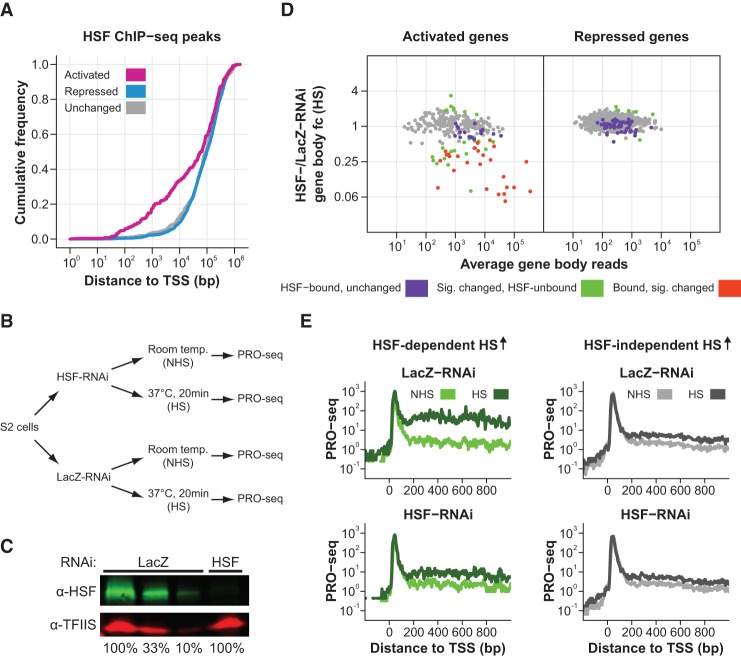
HSF is essential for the induction of only a small minority of HS-activated genes and activates genes by stimulating the release of paused Pol II. (A) Cumulative distribution plots of the distance between the closest HSF ChIP-seq peak and the TSS of each gene in the HS-activated (n = 249), HS-repressed (n = 2300), and unchanged (n = 517) classes. (B) Experimental setup. Drosophila S2 cells were treated with either HSF-RNAi or LacZ-RNAi for 5 d. Nuclei were then isolated for PRO-seq after cells were incubated at room temperature (NHS) or heat-shocked for 20 min (HS). (C) Western blot of whole-cell extracts from LacZ-RNAi-treated and HSF-RNAi-treated cells using antibodies detecting HSF and TFIIS (loading control). One-hundred percent is equivalent to 1.5 × 106 cells. (D) DESeq2 analysis to determine the effect of HSF-RNAi treatment on the PRO-seq gene body reads after HS for the HS-activated and HS-repressed classes. We used DESeq2 to identify significantly changed genes between HSF-RNAi HS and LacZ-RNAi HS cells, and the results are displayed as MA plots. Significantly changed genes were defined using an FDR of 0.001. HSF-bound genes are labeled in purple, significantly changed genes (according to DESeq2) are labeled in green, and genes that are both HSF-bound and significantly changed are labeled in orange. (fc) Fold change. (E) PRO-seq read density between −200 and +1000 bp to the TSS (in 5-bp bins) of genes with HSF-dependent (n = 44) or HSF-independent (n = 197) HS activation (HS ↑) for the LacZ-RNAi and HSF-RNAi data sets before (NHS) and after HS.